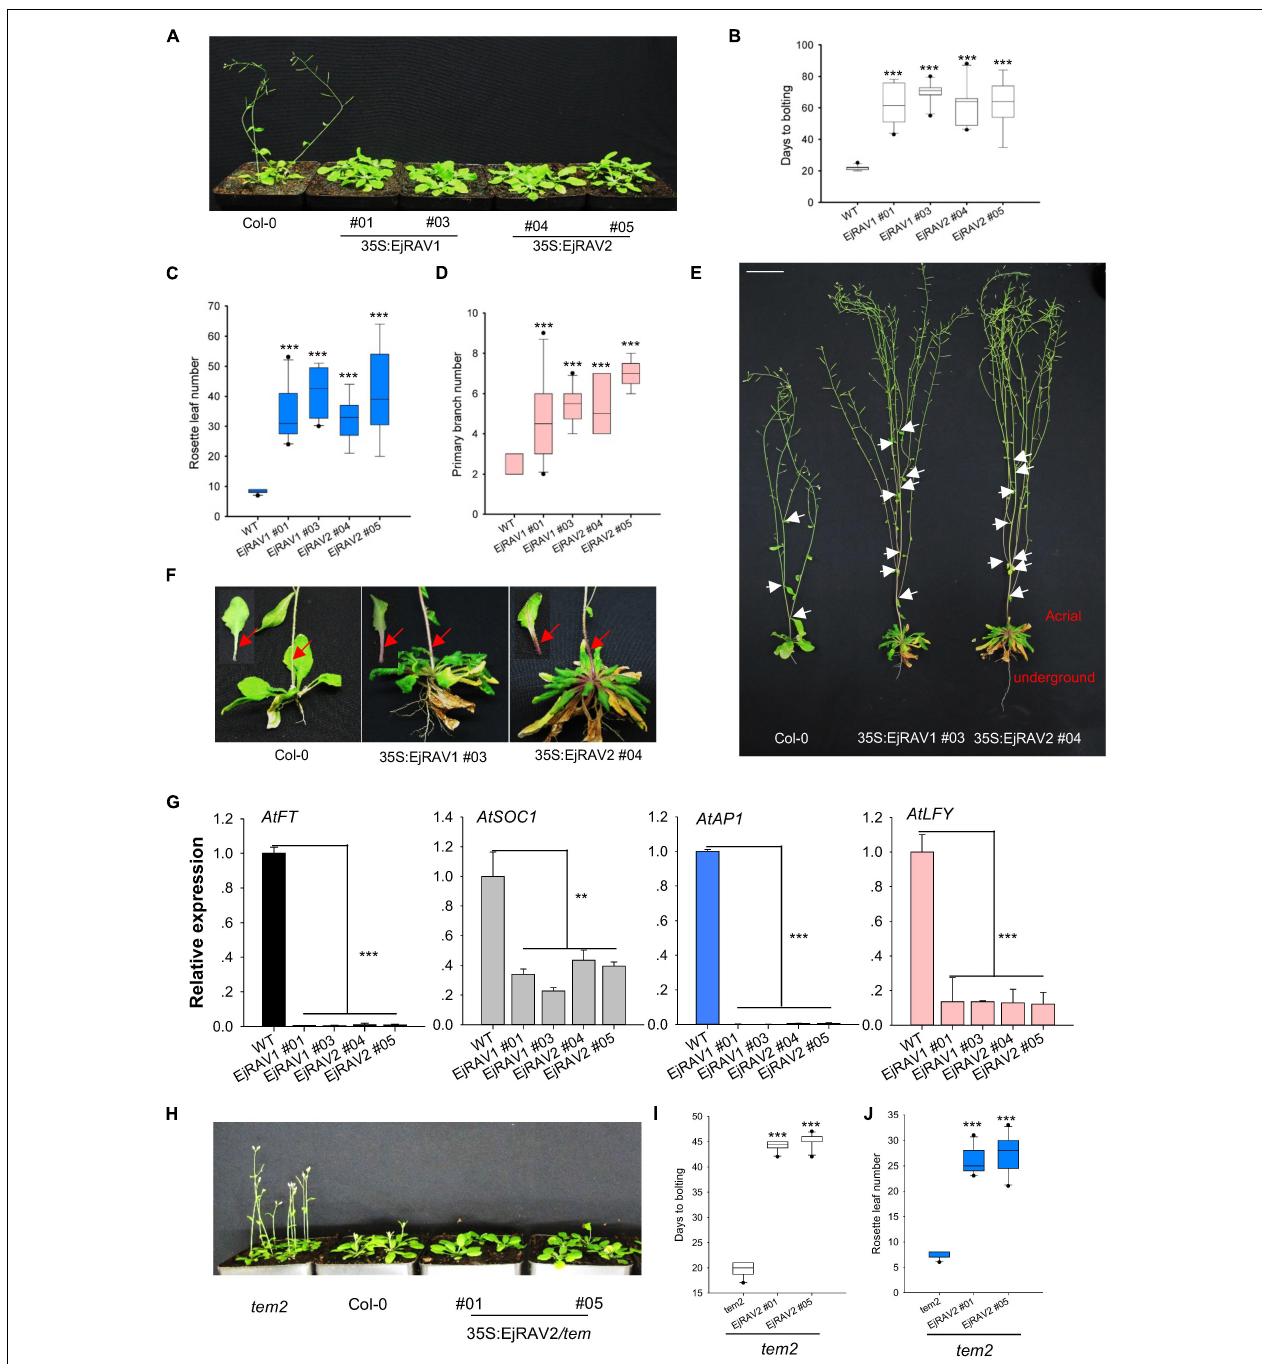
FIGURE 4 | Overexpression of EjRAV1 and EjRAV2 delay flowering and promote stem branching in Arabidopsis thaliana . (A) EjRAV1- OE and EjRAV2- OE delay flowering in Col-0 ecotype Arabidopsis . (B) The juvenile length (days to bolting) of all the overexpressed lines were strikingly prolonged. (C) The numbers of rosette leaves were greatly increased in the EjRAV1/2 -OE lines. (D) EjRAV1- OE and EjRAV2- OE promoted lateral branching. (E) The phenotypes of Col-0 and EjRAV1/2 -OE transgenic Arabidopsis plants. The ectopic expression of EjRAV1/2 was not only involved in the regulation of plant architecture (see leaf floral and axis branch numbers) but also associated with strong root system. Arrows indicate the growing point of the primary branch. (F) EjRAV1/2 -OE activated anthocyanin accumulation in petiole and stem. Arrows represent abundant anthocyanin enriched in the basal parts of petiole and stem. (G) EjRAV1- OE and EjRAV2- OE repressed the expressions of flower inducer genes ( FT , SOC1 , AP1, and LFY ) in Arabidopsis . (H) EjRAV2 -OE rescues the phenotype of tem2 mutant (Col-0 background) to Col-0 at 4 weeks post germination. The (I) juvenile lengths and (J) rosette leaf numbers of the EjRAV2 -OE transgenic plants (on tem2 background). The ** and *** indicate significant differences at P < 0.01 and < 0.001. The error bars in (B–D,I,J) represent standard deviation for 15 T 3 plants. The error bars in (G) represent standard deviation for three replicates.